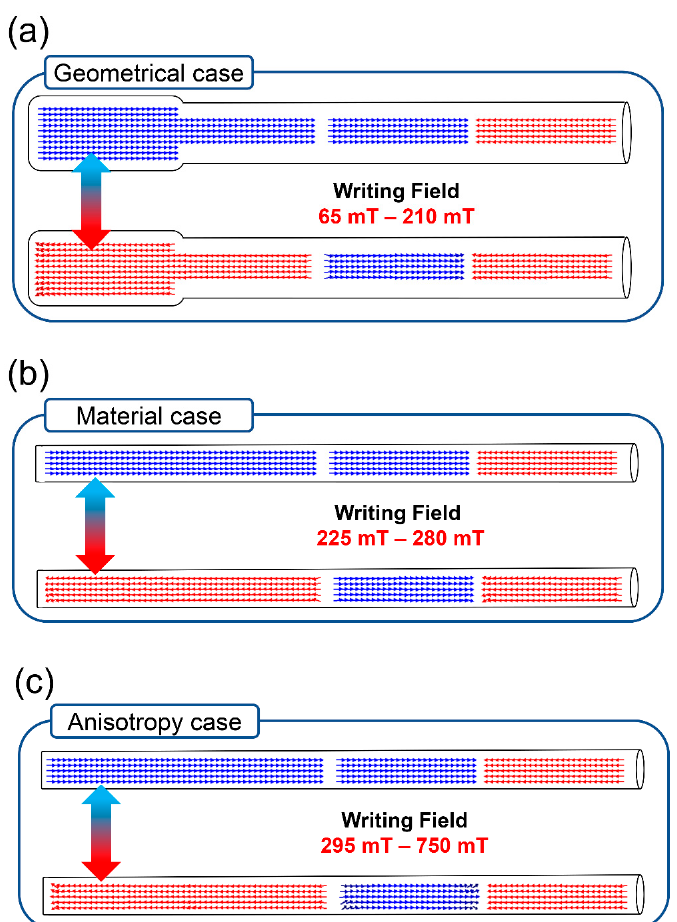
Figure 3. Representation of the low energy state of the ( a ) geometrical, ( b ) material and ( c ) anisotropy cases after applying the magnetic field during the writing process. The lowest and the highest magnetic fields that can be applied to switch from the top stage to the bottom of each case is called writing field.